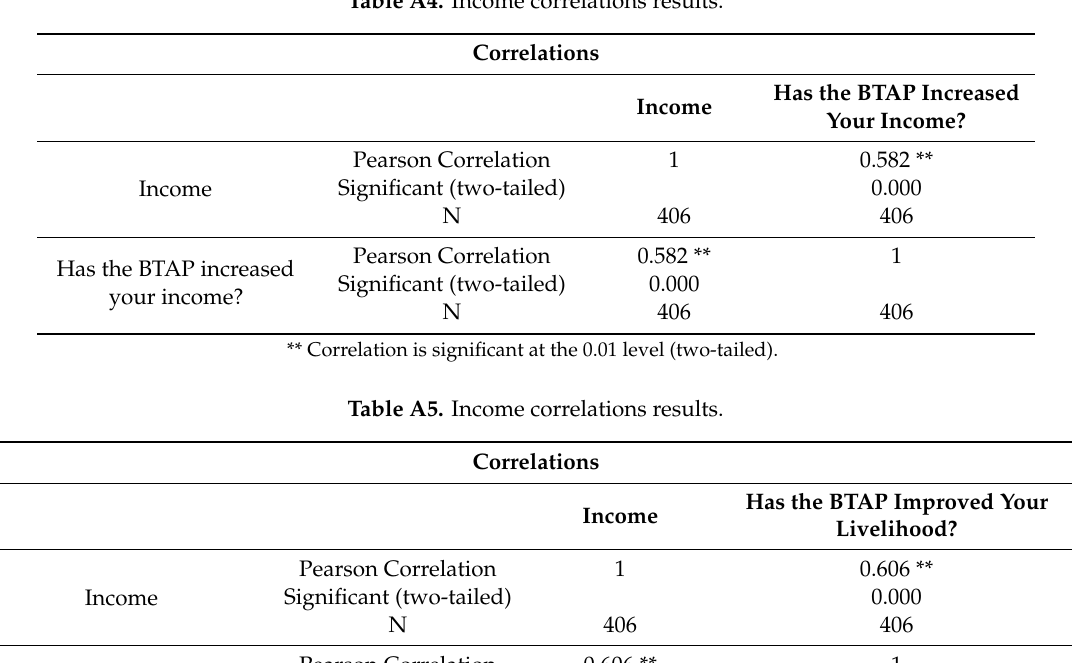
Table A4. Income correlations results.